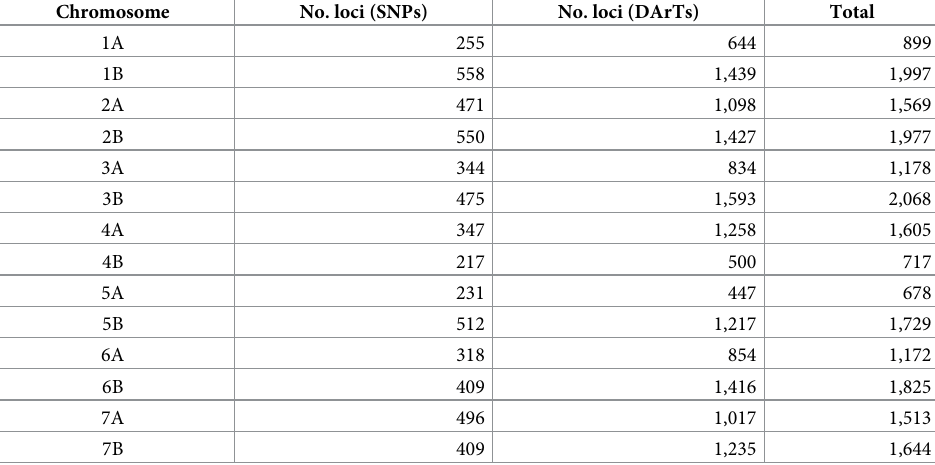
Table 2. Distribution of 5,711 SNP and 14,979 DArT markers mapped across the two constitutive genomes (A, B) of durum wheat.